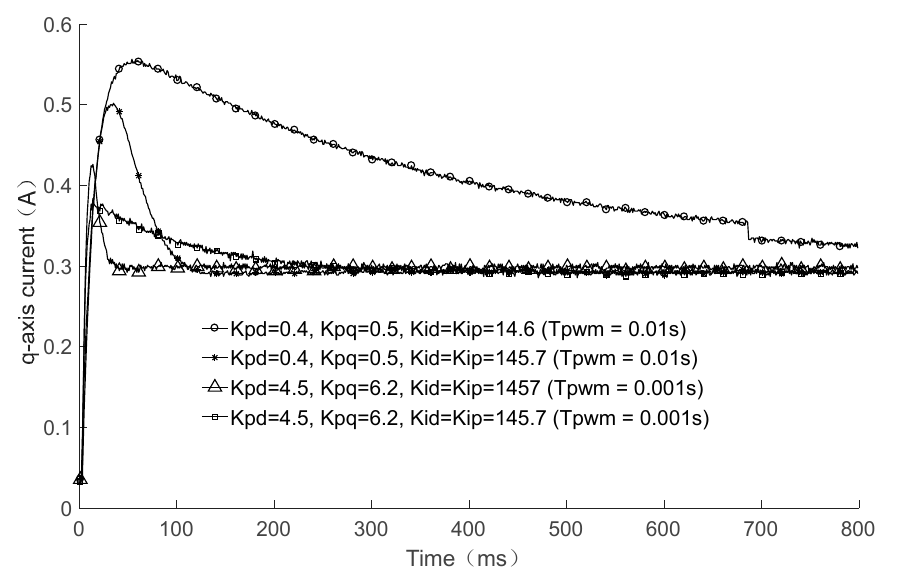
Figure 7. The q-axis current response result of the torque closed-loop control of the PMSM.